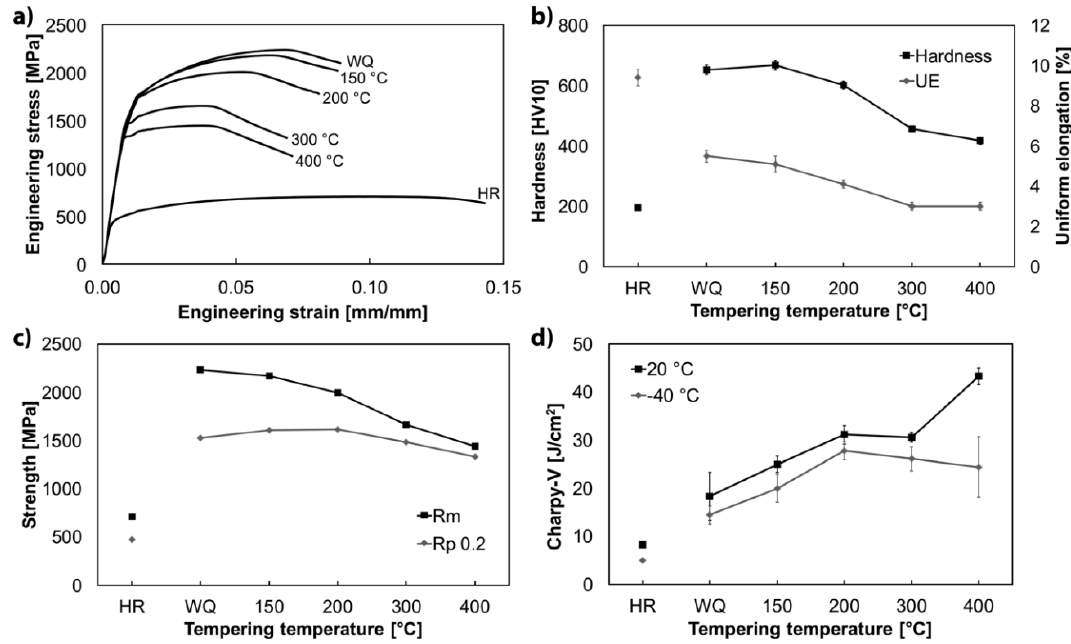
Figure 6. Mechanical properties of the tested steels: ( a ) engineering tensile test curves, ( b ) material hardness and plastic component of the uniform elongation (UE), ( c ) yield strength (0.2% offset, R p0.2 ) and tensile strength (R m ), and ( d ) Charpy- V impact test energies at +20 and −40 °C temperatures. Standard deviations are included in ( b ) – ( d ).